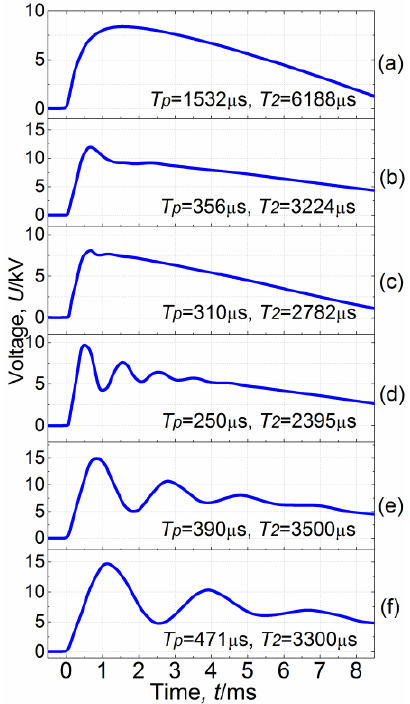
Figure 15. SI waveforms under different circuit parameters.